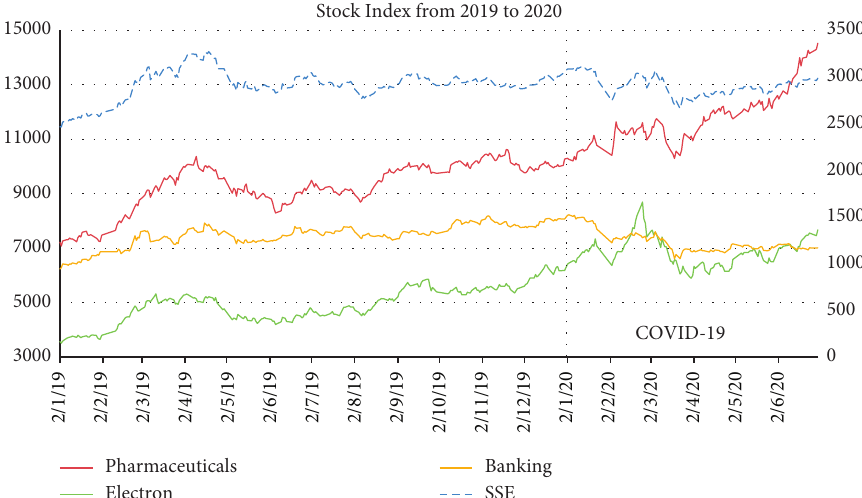
Figure 2: The stock index of the pharmaceuticals, electronics, and banking sectors, and the SSE composite index, 2019 to